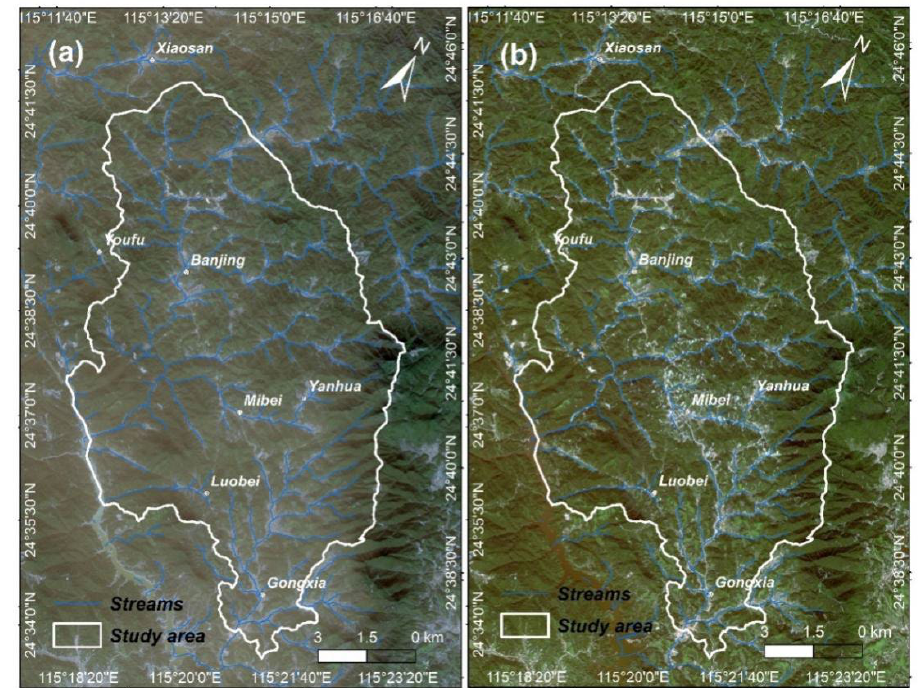
Figure 3. Mapping shows the Sentinel-2 images before and after the rainfall event; ( a ) satellite image before rainfall event taken on 17 April 2019; ( b ) satellite image before rainfall event taken on 24 September 2019.